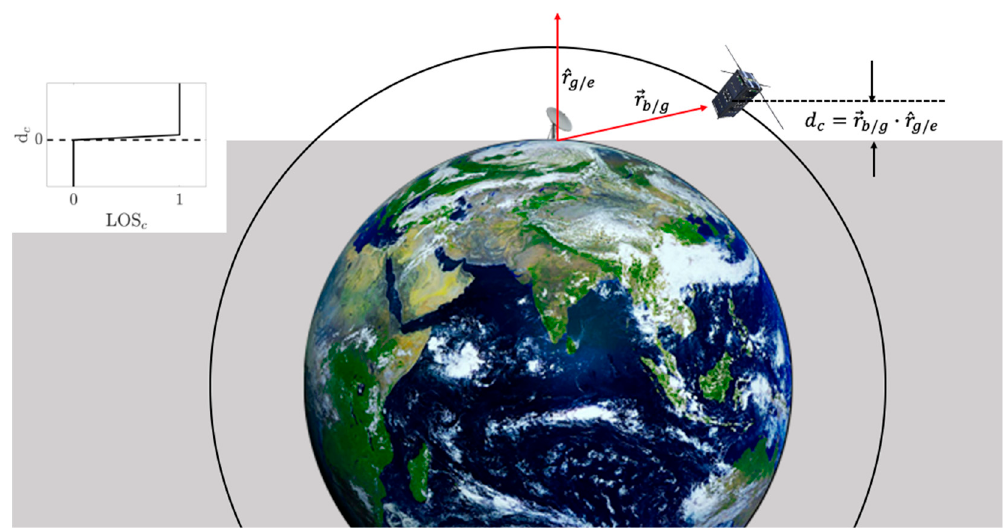
Figure 9. Illustration of communication line-of-sight.